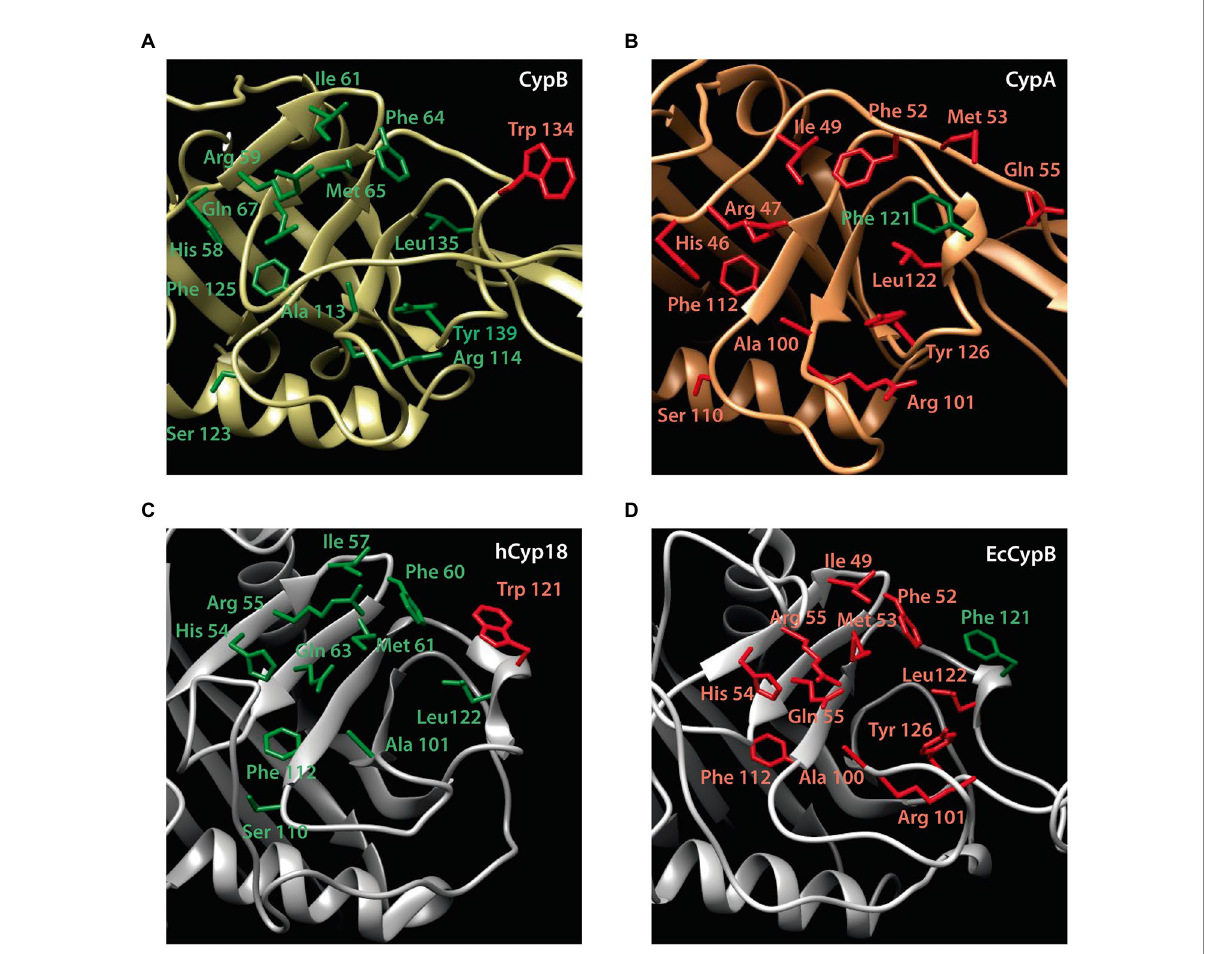
FIGURE 2 Active site structure of Brucella abortus cyclophilins CypB (A) and CypA (B) [in comparison with hCyp18 (2cpl.pdb) (C) and EcCypB (1Lop.pdb) (D) ]. Residues that contribute to the active site of the cyclophilin family are labeled and shown in stick representation. The tryptophan involved in CsA inhibition is highlighted in red for CypB (Trp 134 ) and hCyp18 (Trp 121 ). Phe 121 is highlighted in green for CypA and